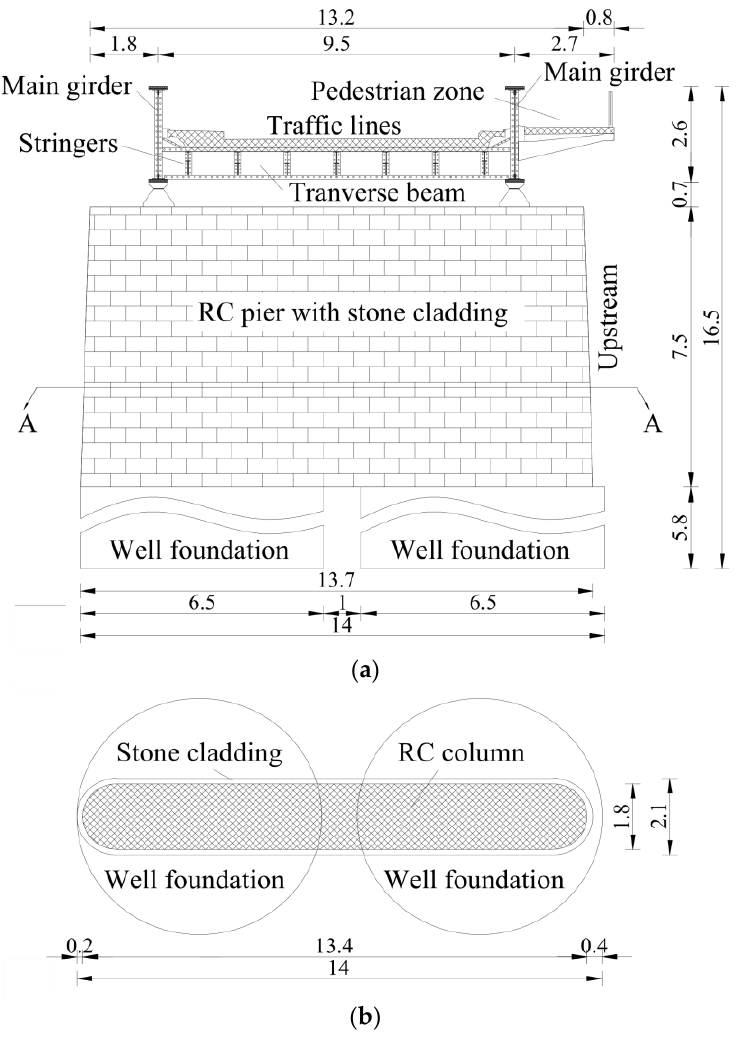
Figure 2. ( a ) Cross-section of the case-study bridge; ( b ) cross-section A-A at the base of the pier. Table 1. Soil characteristics used for modelling the soil–structure interaction at the central pier of the